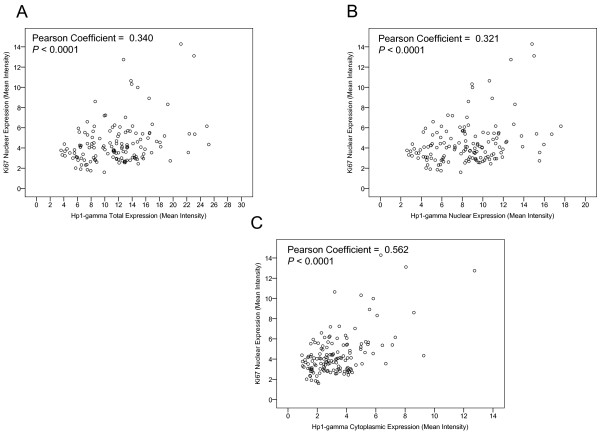
HP1γ expression correlates with Ki-67. VECTRA™ technology was used for automated image attainment and analysis per the manufacturer’s protocol to assess immunoflourescent staining of Ki-67 and HP1γ. Pearson correlation coefficients yielded significant relationships between mean intensity expression of nuclear Ki-67 and A) total ( P = 0.34), B) nuclear ( P = 0.32), and C) cytoplasmic ( P = 0.562) HP1γ. All P values <0.0001.